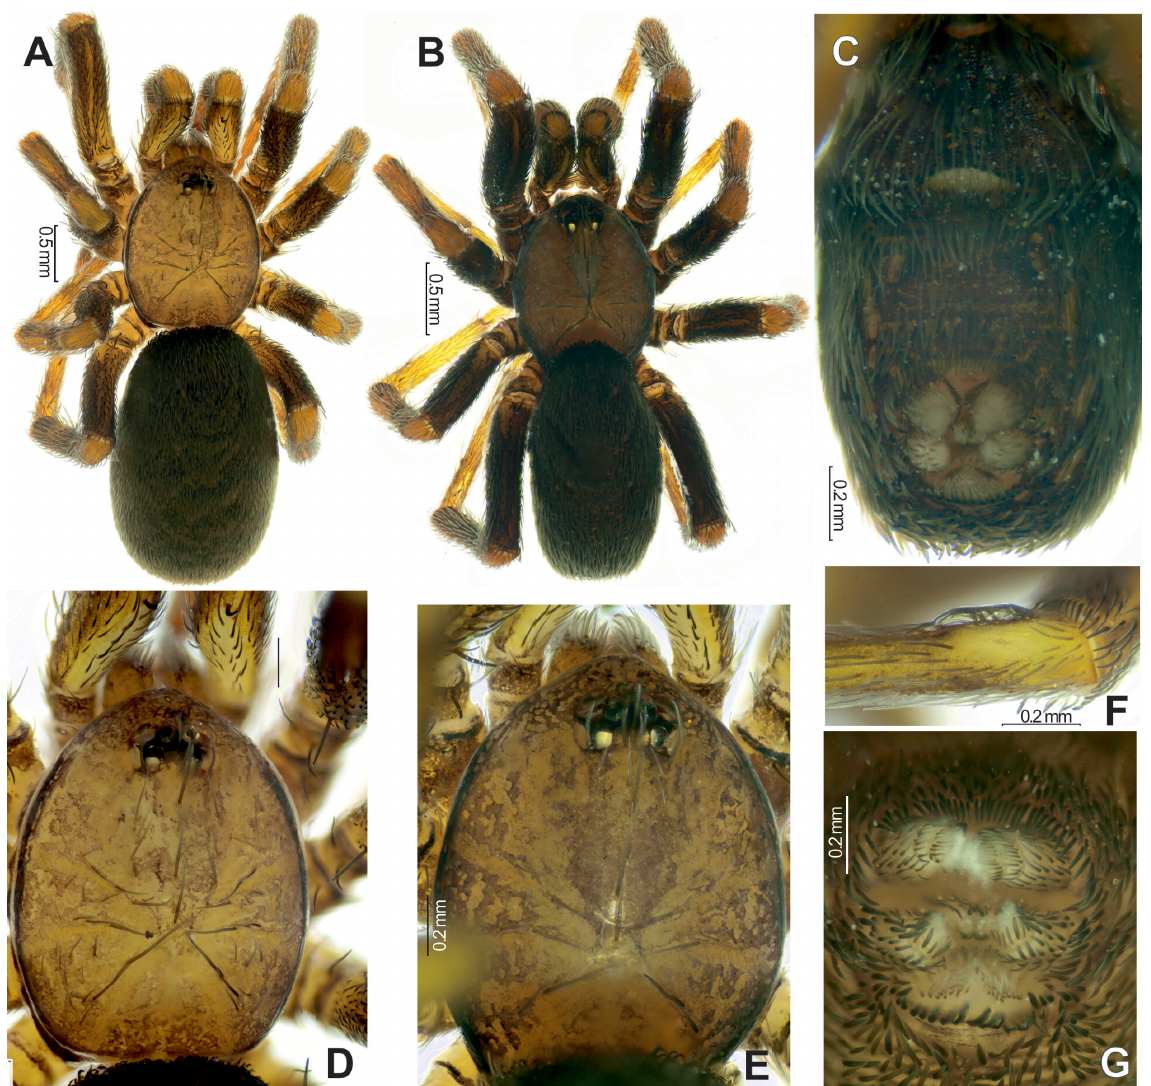
Fig. 6. Somatic characters of Zaitunia schmitzi (Kulczyński, 1911), ♀ ( A , C–D , F–G ) and ♂ ( B , E ) from Jerusalem area. — A–B . Habitus, dorsal. C . abdomen, ventral. D – E . Prosoma, dorsal. F . Calamistrum, dorsal. G . Spinnerets,